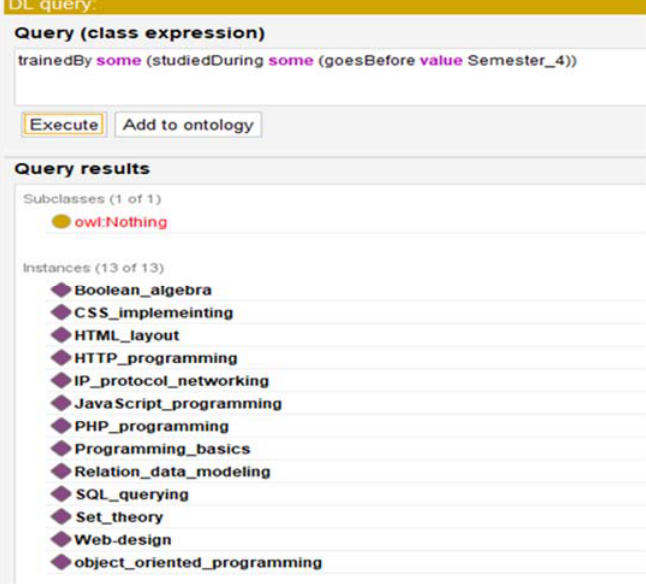
Figure 11. The list of skills acquired by the student during the study of courses preceding the 4th semester.